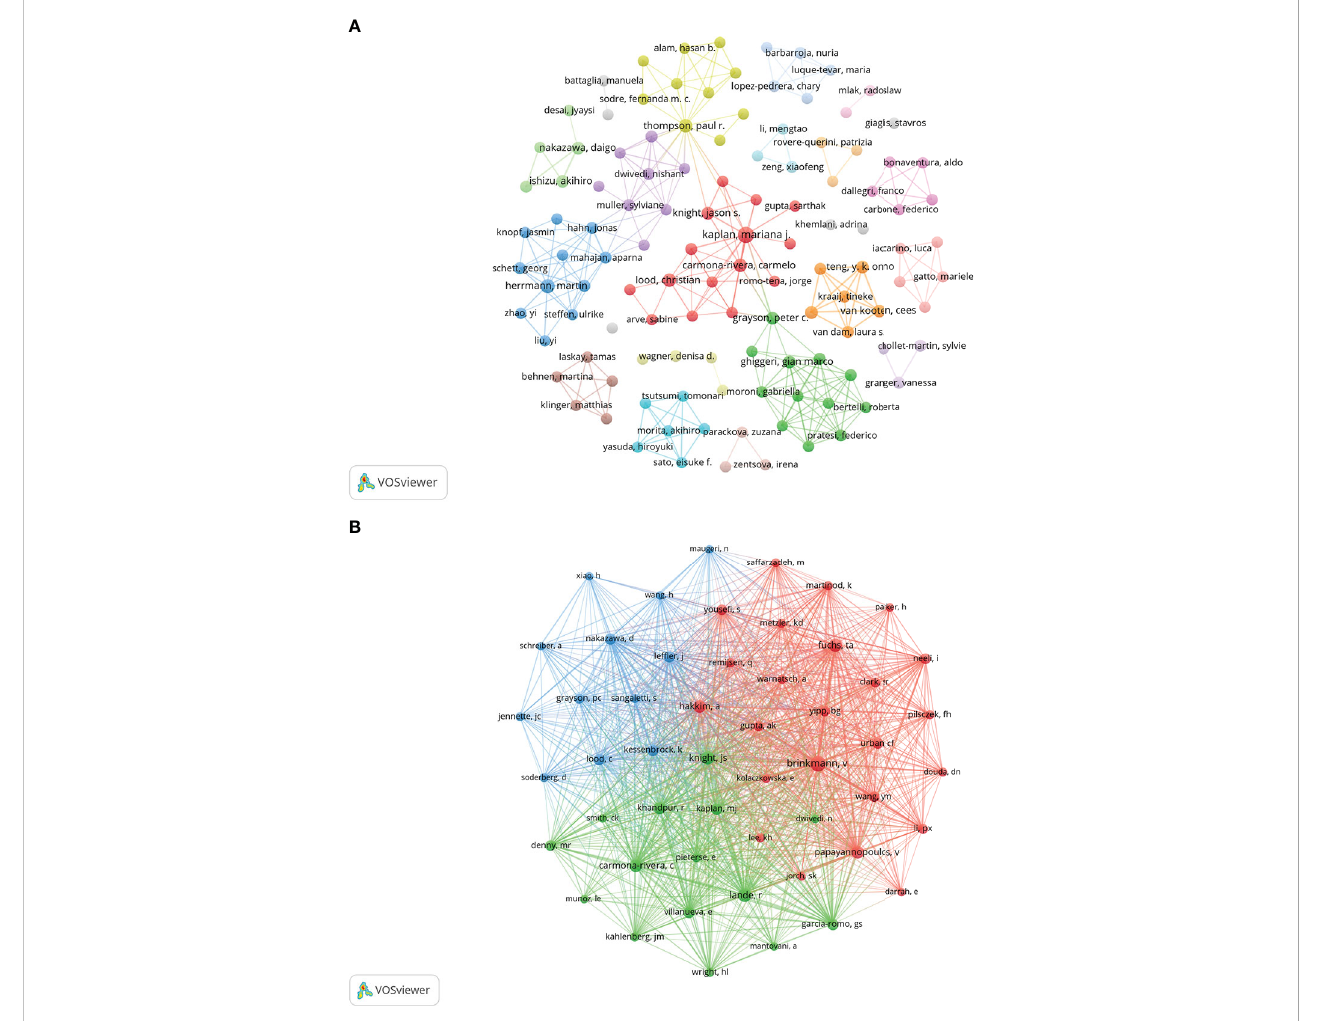
FIGURE 6 Visualization of authors (A) and co-cited Authors (B) on the research of NETs in